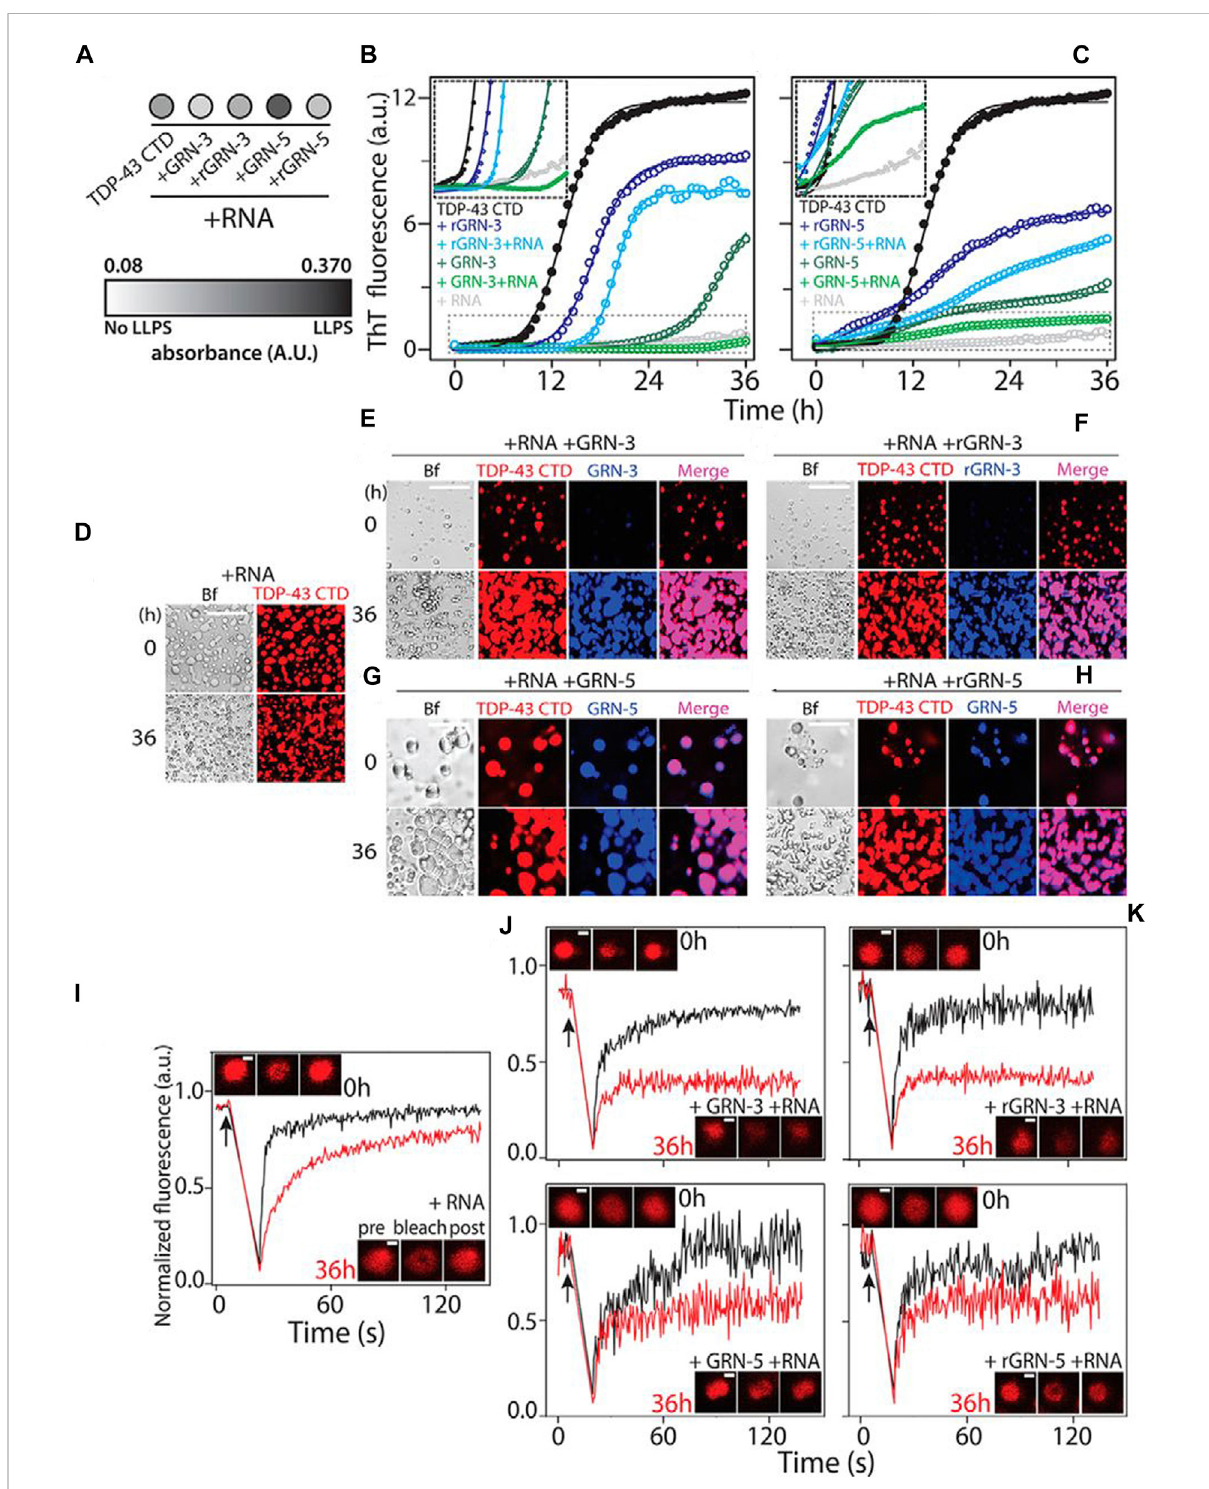
Modulation of TDP-43 CTD – RNA LDs by GRNs. (A) Turbidity measured at 600 nm within 10 min of incubation for co-incubated solutions of 20 μ m TDP-43 CTD with 40 μ m GRN-3 or GRN-5 (reduced and oxidized) in the presence or absence of 40 μ g/ml RNA ( n = 3). (B) and (C)